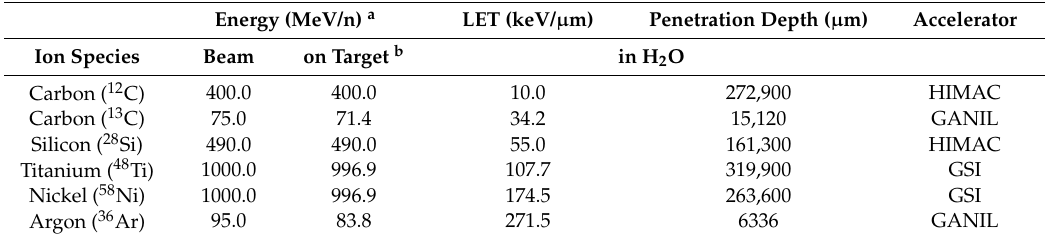
Table 5. Characteristics of the heavy ion